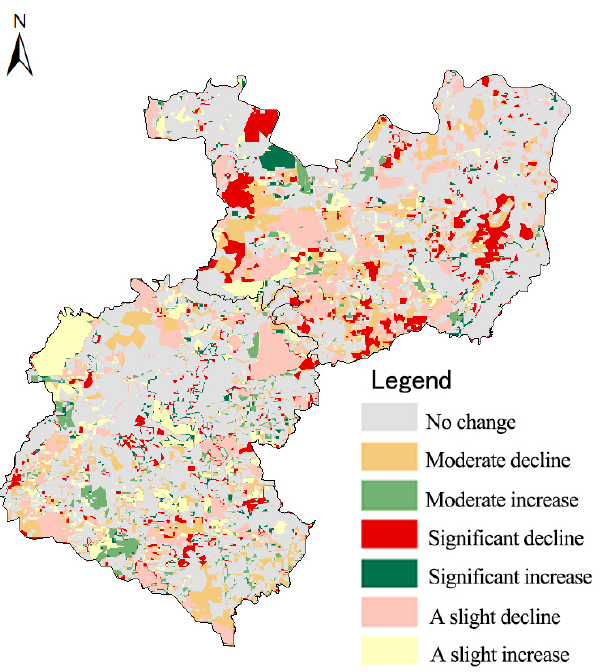
Figure 9. The degree of habitat quality degradation in the study area from 2000 to 2017.